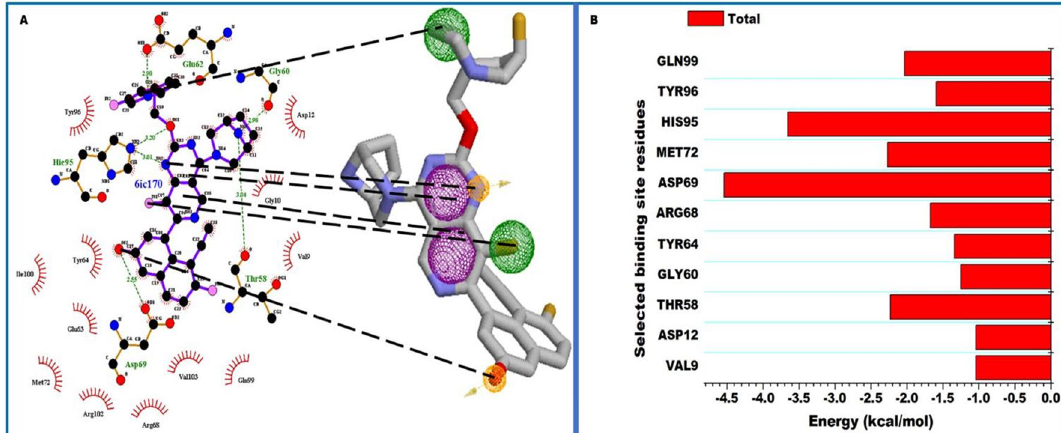
Figure 6. A pharmacophore model of MRTX1133. ( A ) 2D illustration of MRTX1133 interacting with binding site residues after 450 ns MD simulation. ( B ) The selected pharmacophoric moieties in MRTX1133, which interacted with the most negative energy contributing binding site residues. ( C ) PRED plot highlighting only the total binding energy contributed by the selected active site residues.